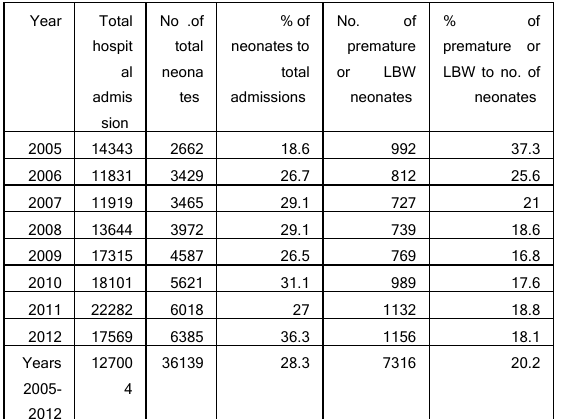
Table 1 : contribution of neonatal